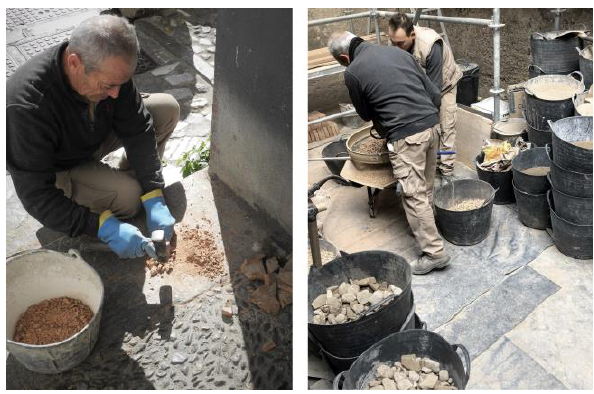
Figure 4. Chamotte preparatory works and development stage of the different masses of earth.